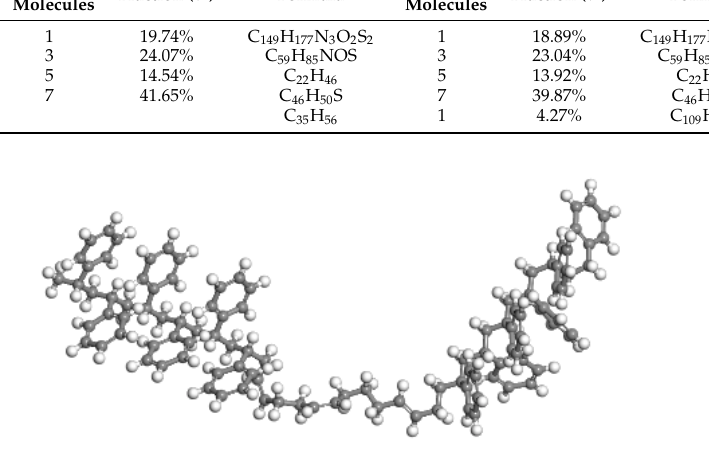
Figure 3. SBS modifier molecular model.